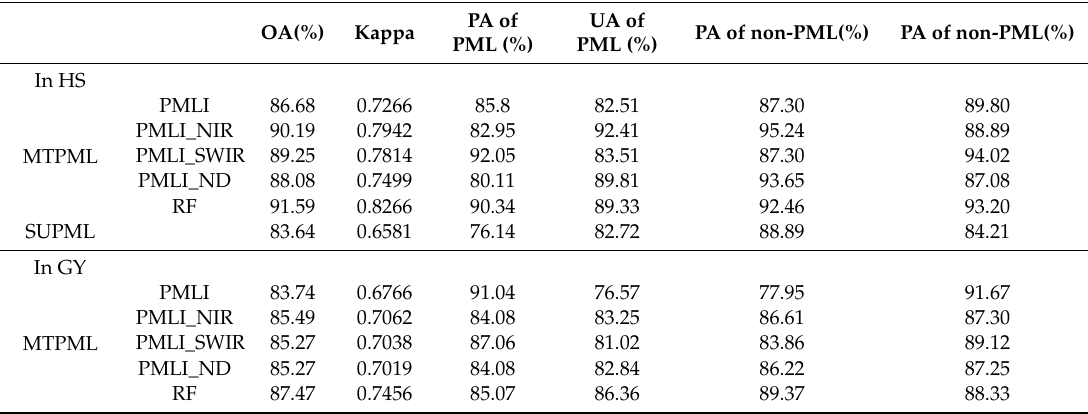
Table 3. Classification accuracies assessment in HS and GY.